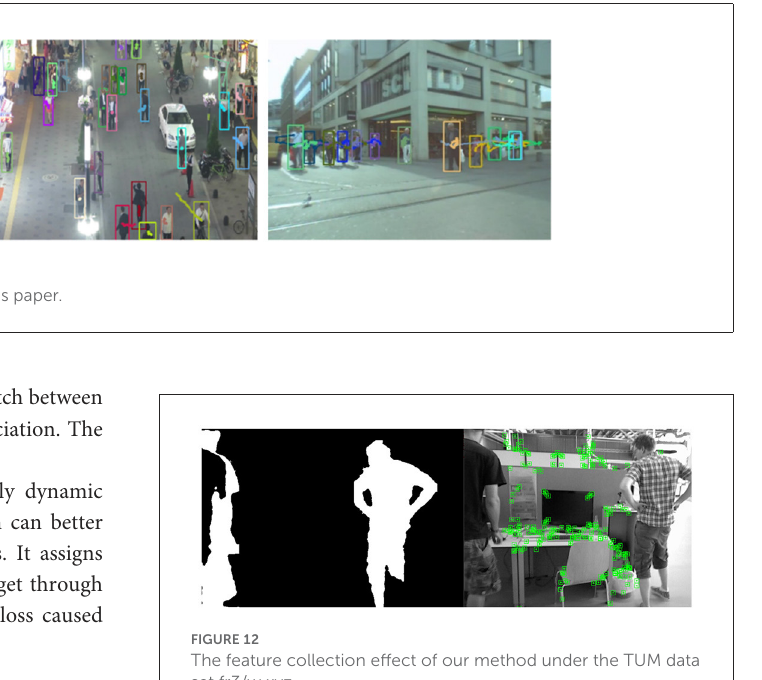
error for each camera pose are represented as the black, blue, and red segments, respectively. The algorithm